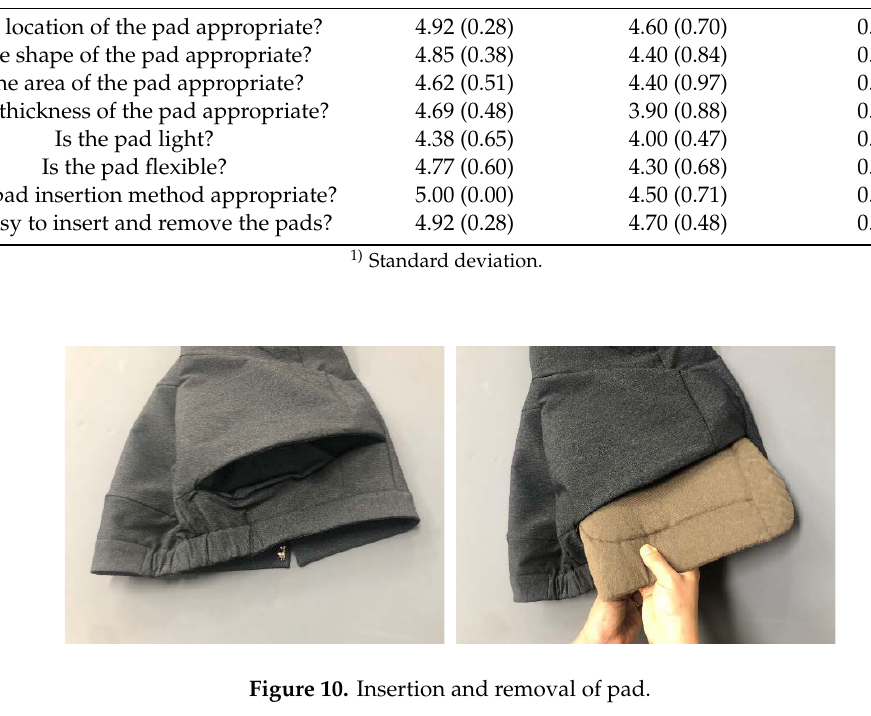
Table 9. Results of the evaluation of motion functionality ( n = 13).